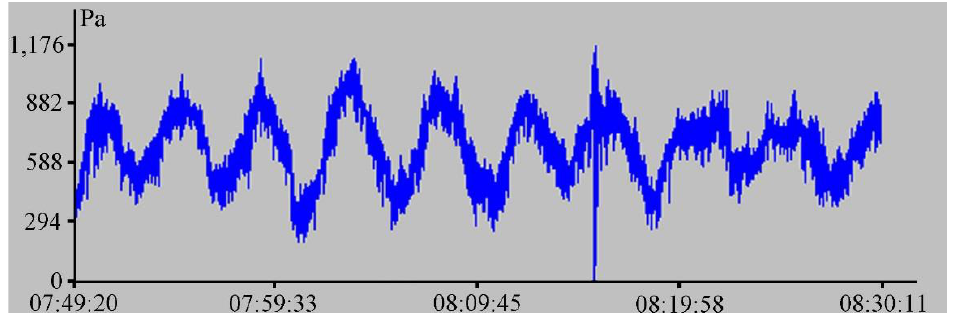
Figure 8. A recording section of the supersensitive detector of hydrosphere pressure variations for 27 September 2020, installed on the seabed at a depth of 4 m in Alekseev Bay, Popov Island with the registration of a nonlinear hydrophysical disturbance of the rogue wave type against the background of seiches of local origin.